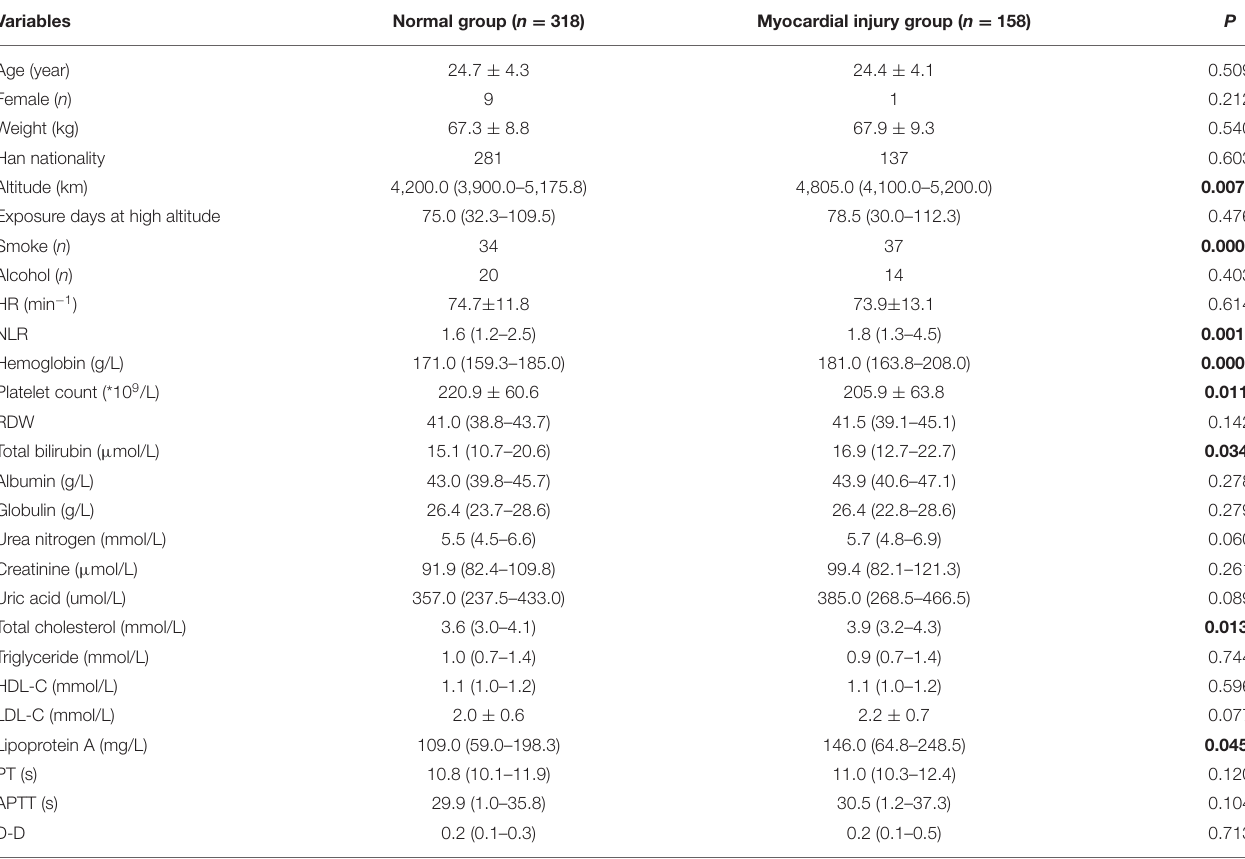
TABLE 1 | Univariate analysis of factors related to myocardial injury in population at high altitude.